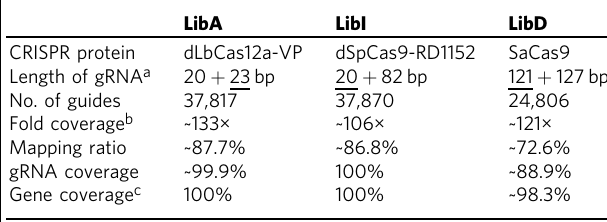
Table 1, X3, X4, XI1, XI3, XII2, XII4, and XII5 together with their corresponding gRNAs were chosen for CRISPR-assisted and marker-less integration of gRNA expression cassettes.